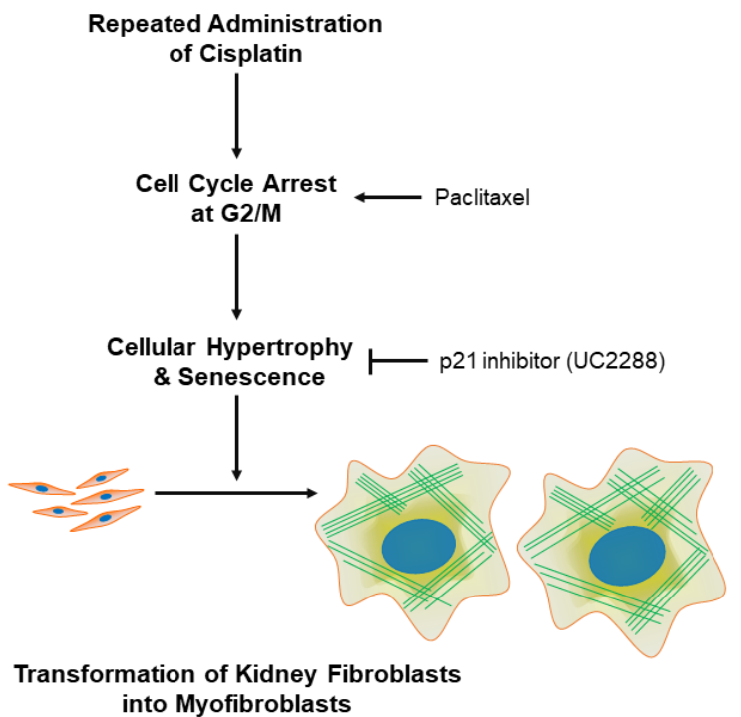
Figure 9. Scheme of mechanism of kidney fibroblast-to-myofibroblast transformation during exposure to RAC.